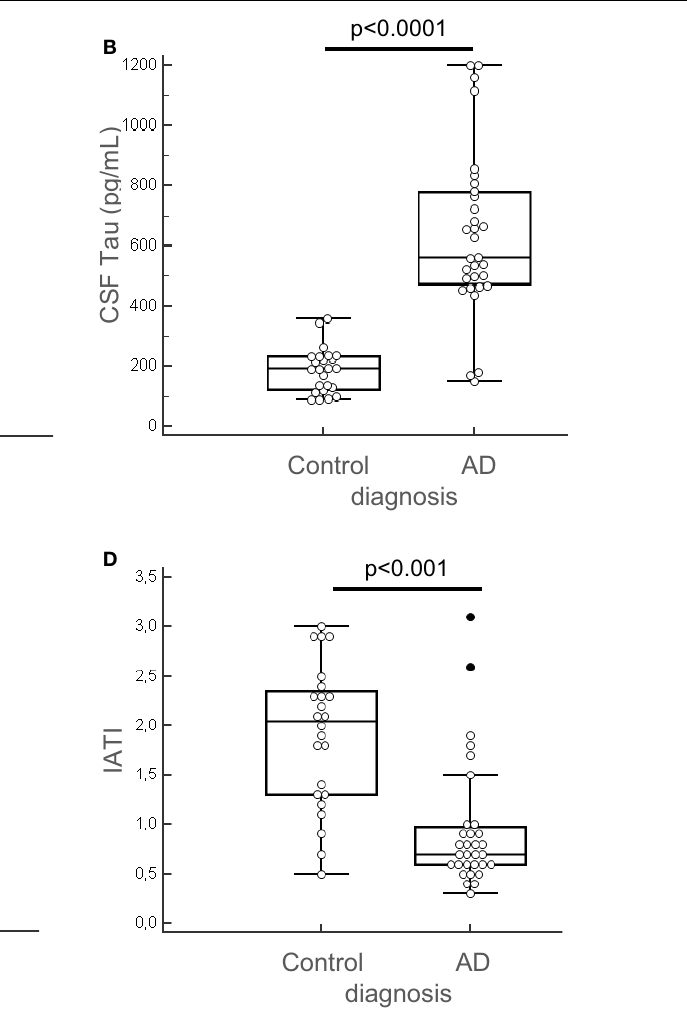
FIGURE 3 | Clinical biochemical characterization of patients . The 55 patients (AD, n = 31 and control subjects, n = 24) of the enlarged cohort used for the second part of the study were characterized clinically and quantified for CSF biomarkers: A β 42, tau, and p-tau, using Fujirebio ELISA quantification kits